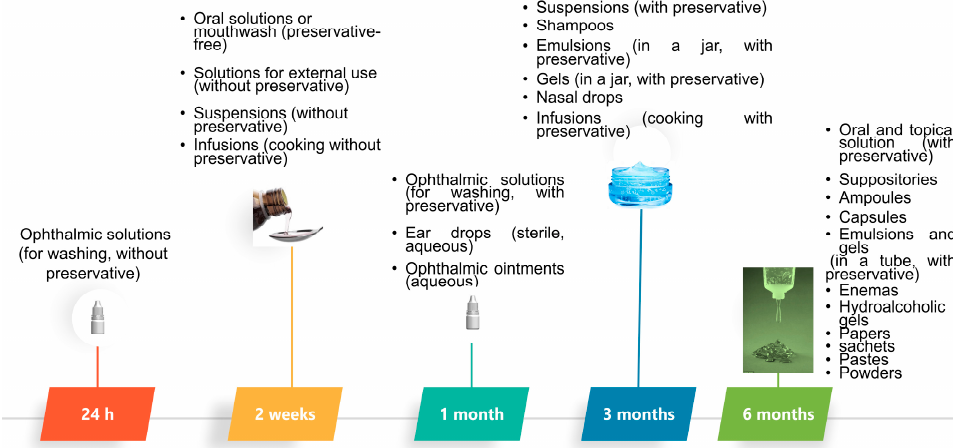
Figure 6. Recommended shelf life for extemporaneous compounding formulations. Modified from: [20].